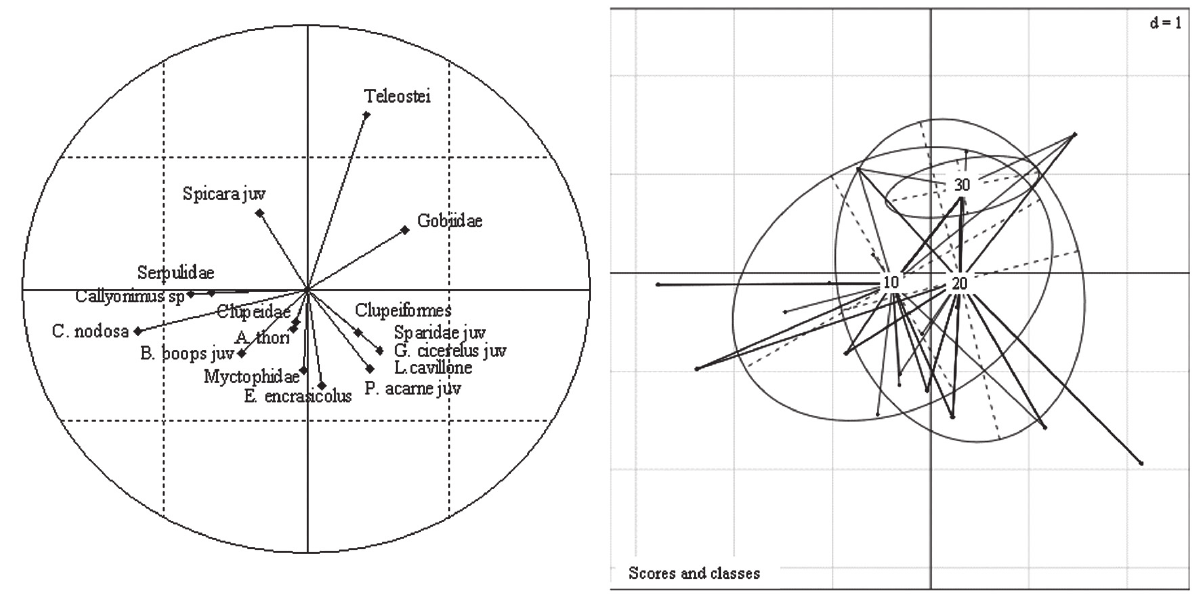
Fig . 5 – correspondence discriminant analysis (cda) computed for depth explaining 100% of the total variance.